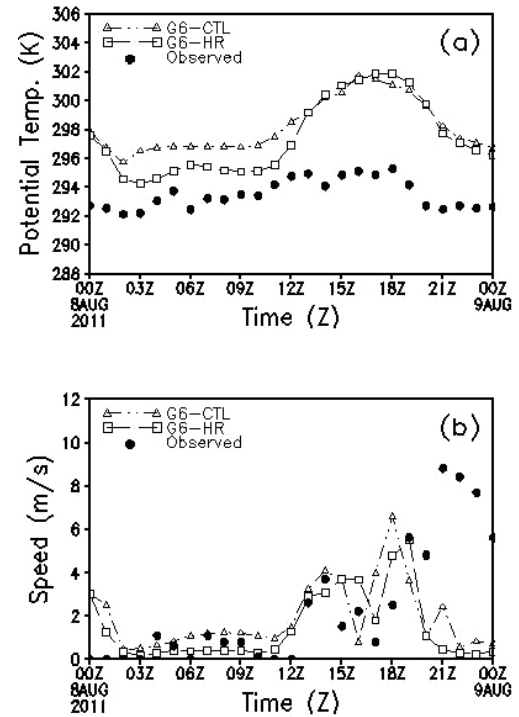
Figure 12. Time cross-section data of (a) θ (K), and (b) wind speed (ms − 1 ) observed (closed circle) and simulated by G6 of the CTL (open triangle) and HR (open square) runs from 00:00UTC 8 August to 00:00UTC 9 August 2011 at Xerem surface weather- observation